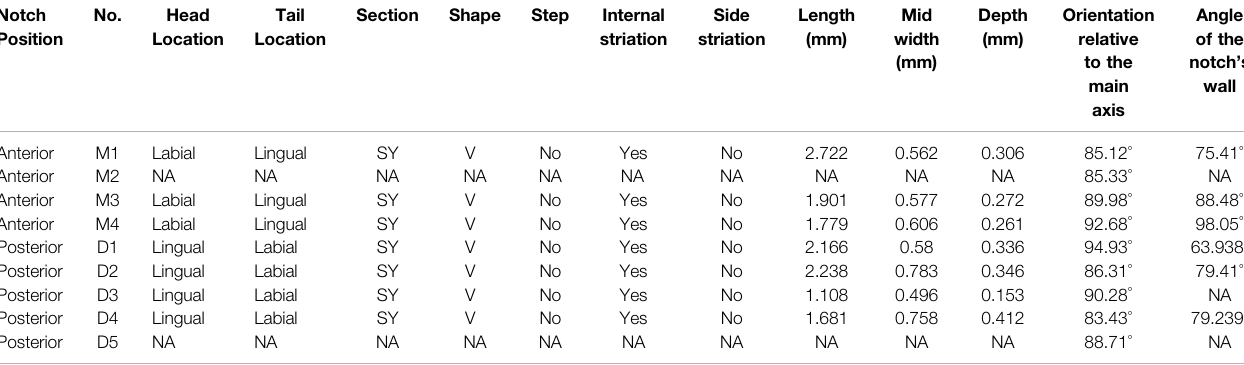
TABLE 1 | Morphometric and technological data on the notches incised on the QG10 perforated red deer tooth. Notch Position